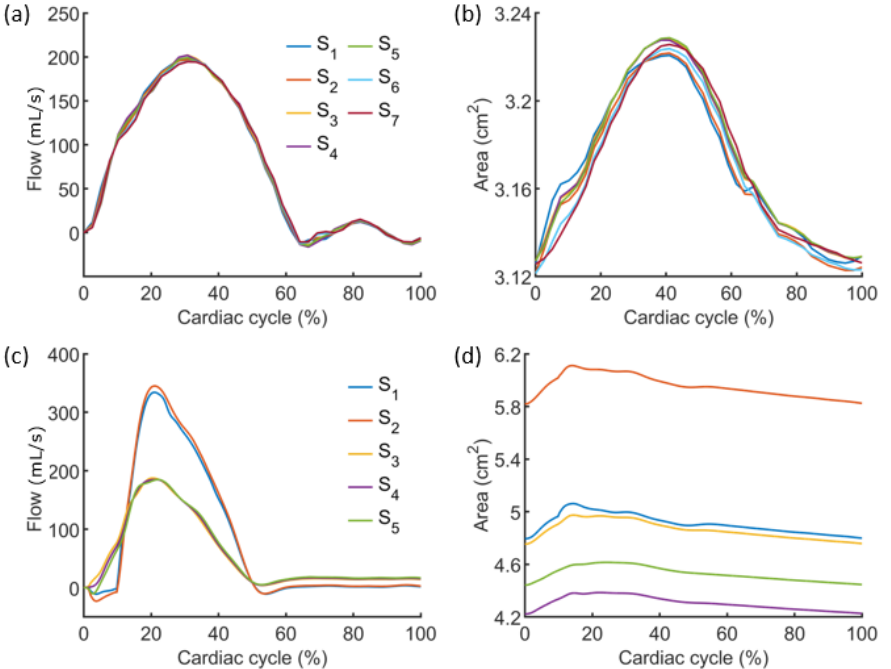
Figure 8. Flow (left panel) and area (right panel) variations along the cardiac cycles for all the selected sections S for the U-shaped model M 1 ( a , b ) and the patient-specific aortic model M 2 ( c , d ), referred to the simulation with E = 1.7